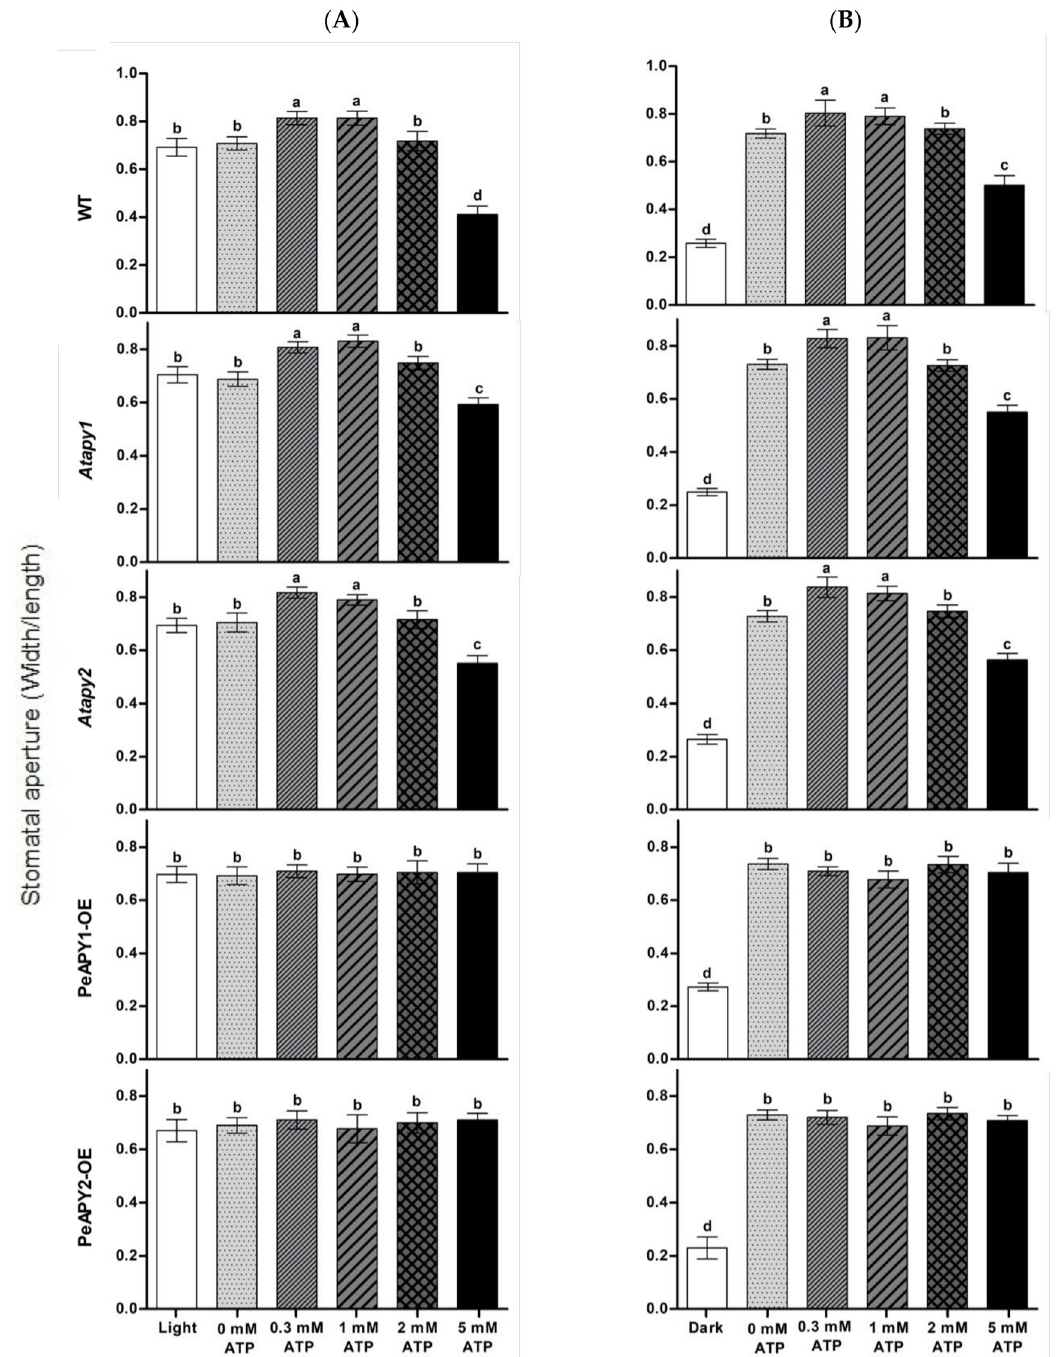
Figure 2. Effects of ATP on stomatal aperture in wild-type (WT), Arabidopsis loss-of-function mutants for APY1 and APY2 ( Atapy1 and Atapy2 ) and transgenic lines of PeAPY1 and PeAPY2 (PeAPY1-OE and PeAPY2-OE). Leaves from three-week-old seedlings were incubated in MES-Tris buffer containing 50 mM KCl and 10 mM MES-Tris (pH 6.15) in light (150 µ mol m − 2 s − 1 ) ( A ) or in darkness ( B ). Thereafter, leaves were exposed to different concentrations of eATP (0, 0.3, 1.0, 2.0 or 5.0 mM) for 2 h in cool light (150 µ mol m − 2 s − 1 ). Stomatal aperture was measured in continuously illuminated leaves ( A ) and dark-adapted leaves transferred to light ( B ), respectively. Each column is the mean of three independent experiments, and error bars represent SE. Columns labeled with different letters, a, b, c and d, showed a significant difference at p < 0.05 between treatments and genotypes under conditions of continuous light ( A ) or dark-adapted leaves transferred to light ( B